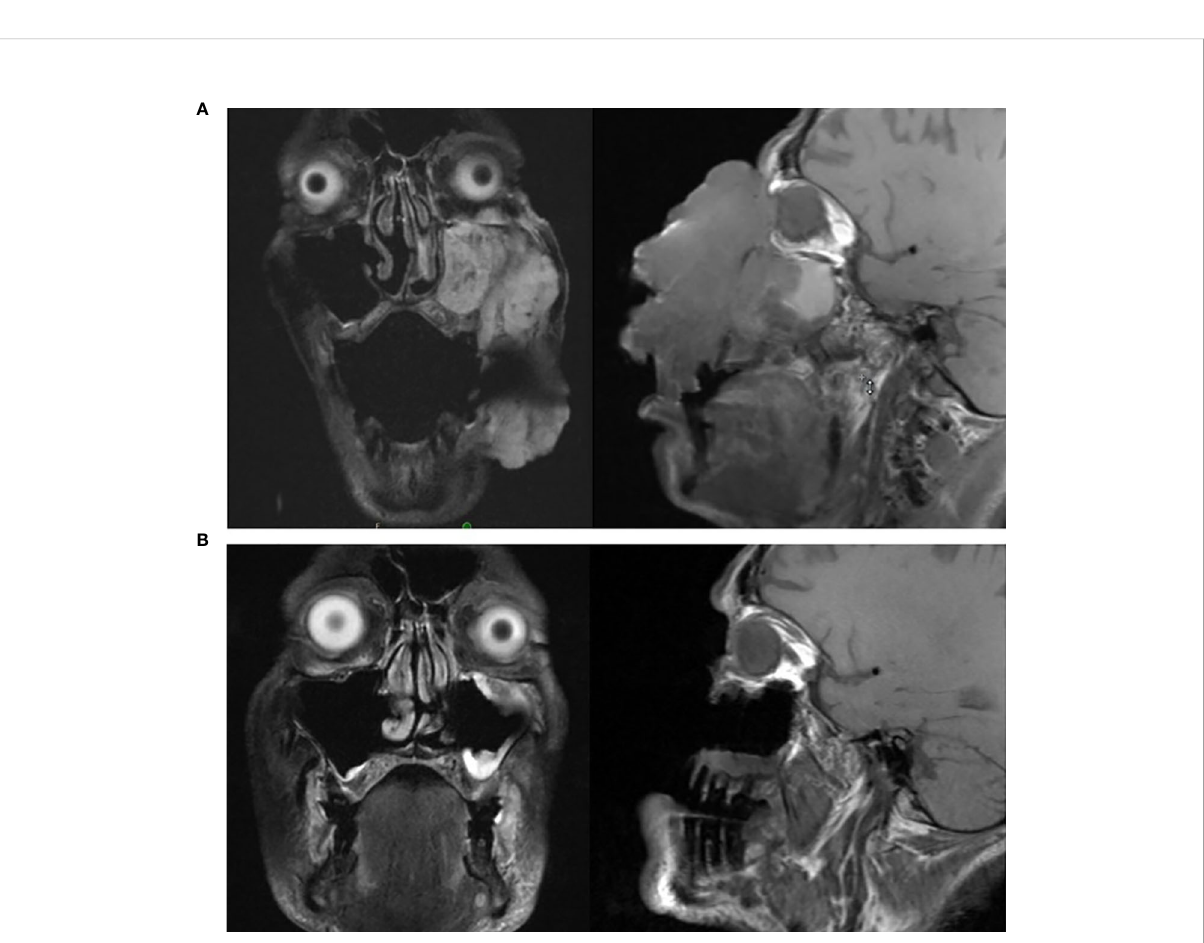
FIGURE 3 (A, B) : (A) (top): MRI of head prior to initiating cemiplimab; (B) (bottom): MRI of head following completion of